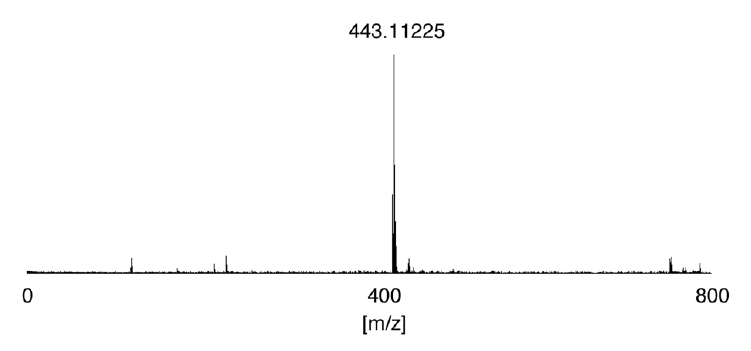
Figure 3. Mass spectrum of flavin-CG ( 2 ) obtained in negative-ion